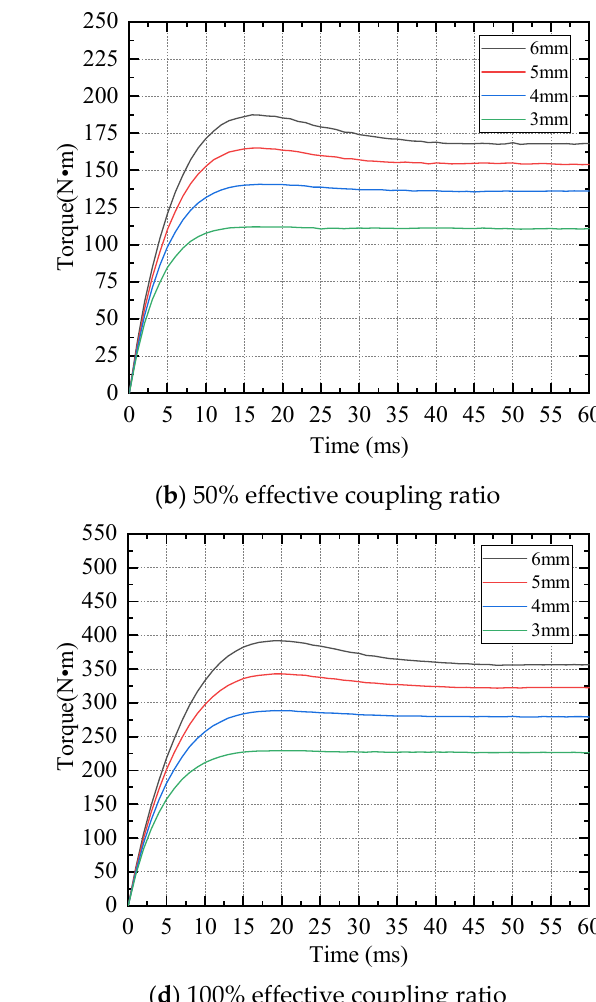
Table 3. Output torque at different copper ring thicknesses.